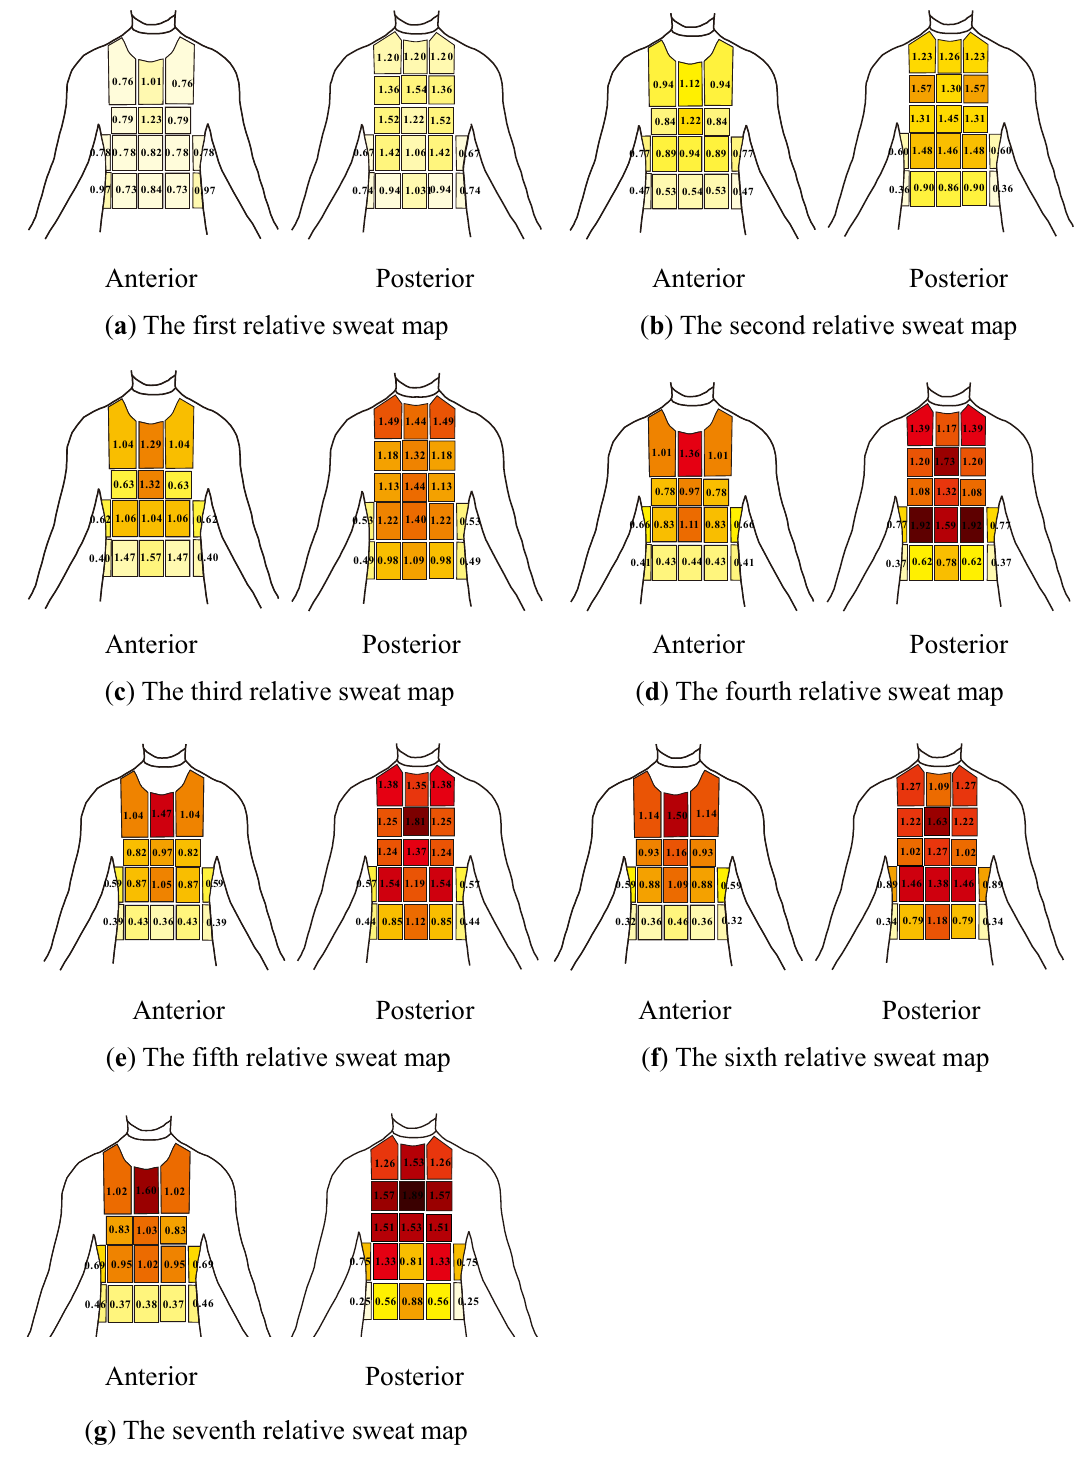
Figure 6. Relative regional sweat rates of participants wearing FCPE. Figures were created using Coreldraw Version